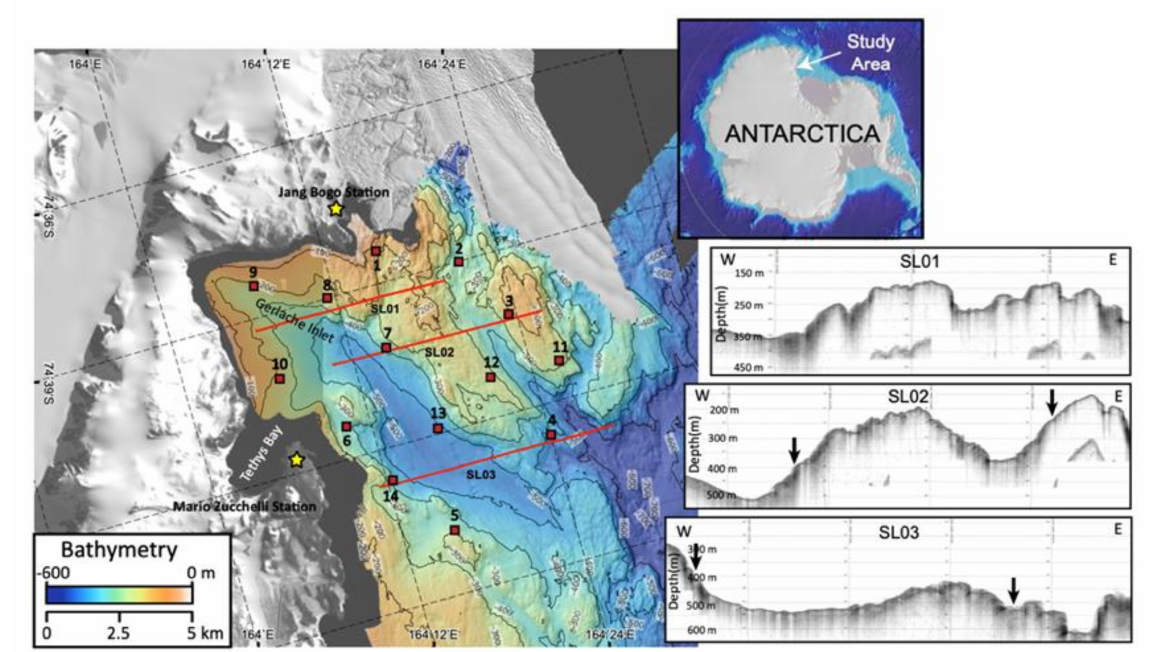
Figure 1. Sampling location, multibeam bathymetry data, and sub-bottom profiles of Terra Nova Bay, Antarctica. The arrows on the sub-bottom profiles indicate coring stations.